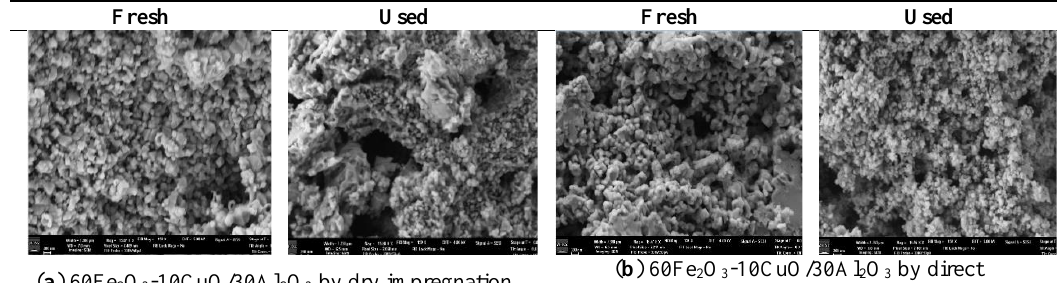
◦ C at a heating rate of